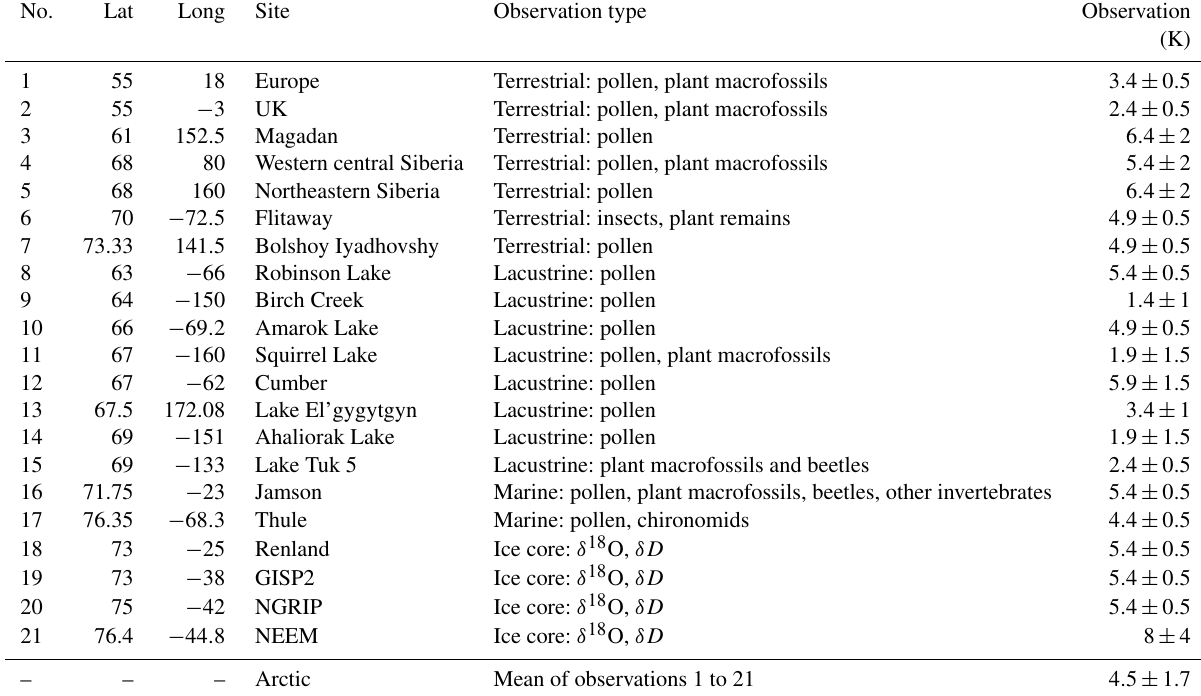
Table 1. Compilation of LIG-PI summertime surface air temperature (SSAT) anomalies used by Guarino et al. (2020b). No. Lat Observation type